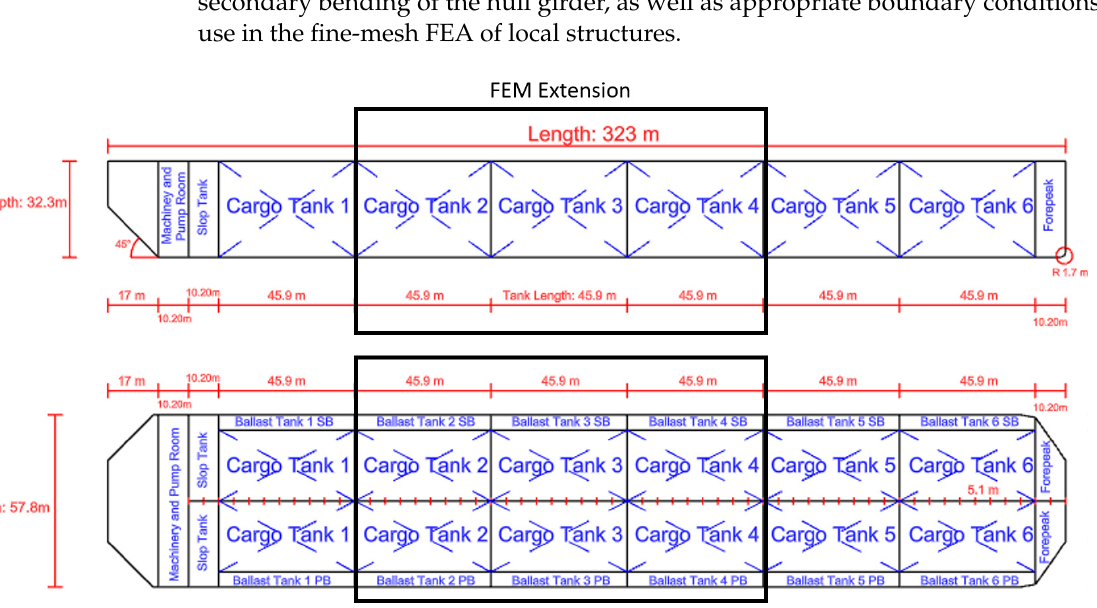
Table 6. Calculations of the weight for each part of the structure for both arrangements. Structure